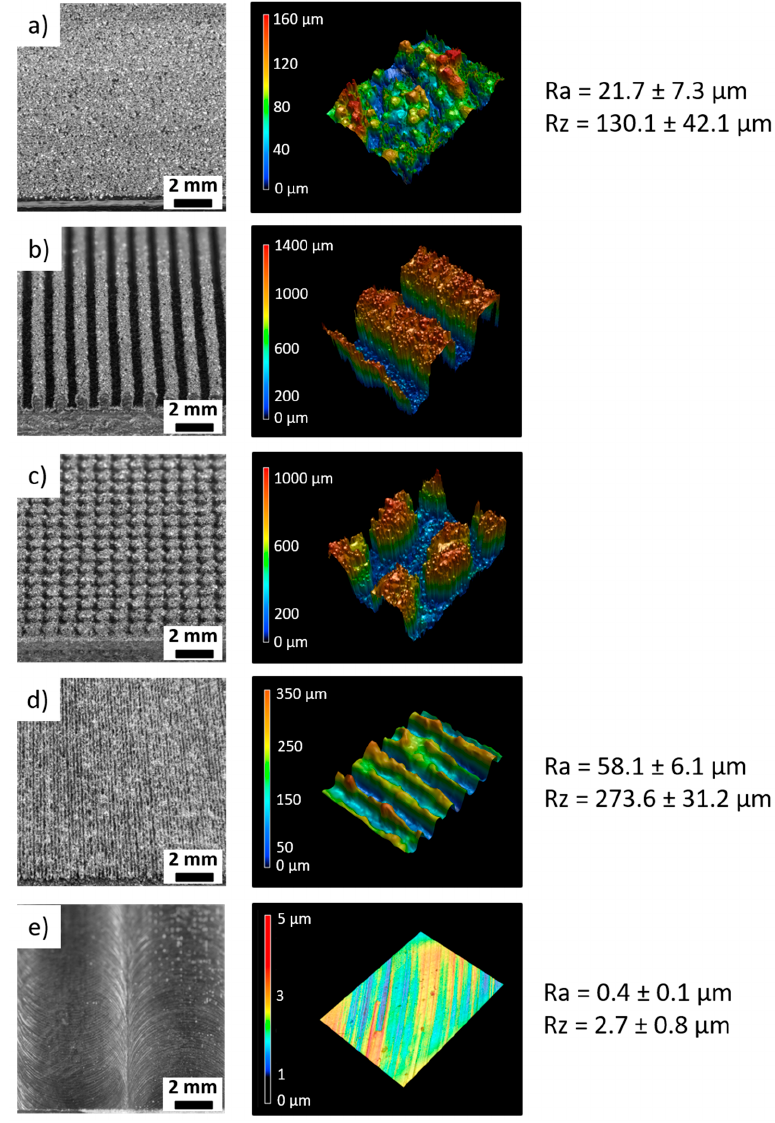
Figure 4. Close-up view (left) and laser scanning confocal microscopy images (right) of titanium samples with ( a ) as-built surface, ( b ) groove-shaped surface structures, ( c ) pin-shaped surface structures, ( d ) laser structured surface, ( e ) milled surface . If applicable, the roughness values Ra and Rz are presented next to the confocal microscopy images.